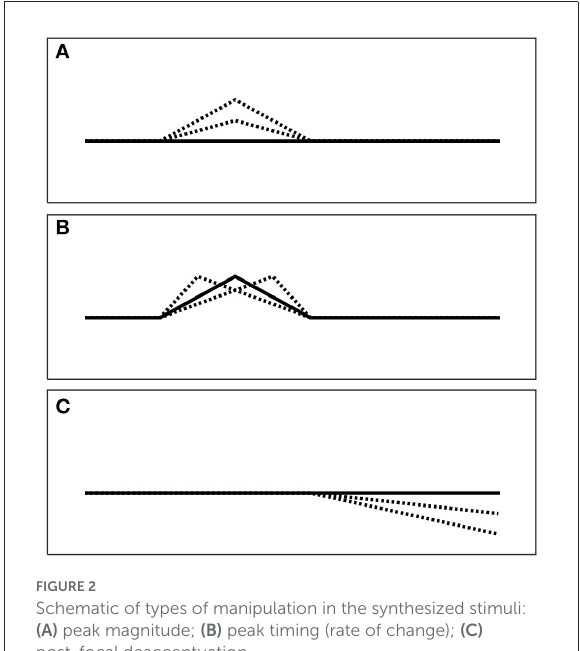
FIGURE2 Schematic of types of manipulation in the synthesized stimuli: (A) peak magnitude; (B) peak timing (rate of change); (C) post-focal